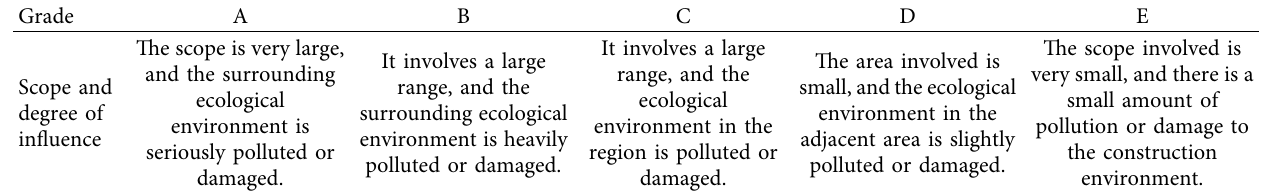
Table 5: Environmental impact level standard.